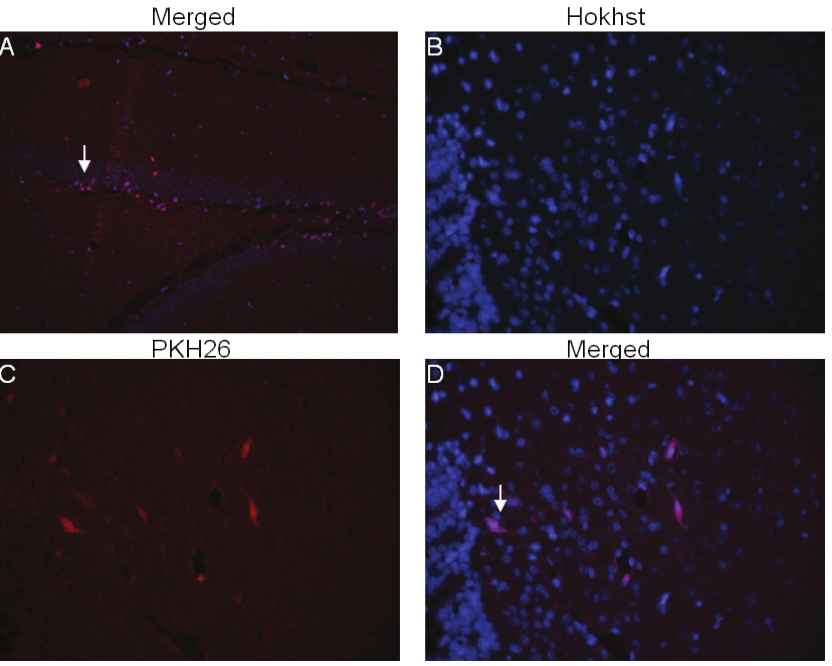
Figure 11: PKH 26 was used to determine stem cell migration into the brain. The sections were obtained 150 days after intravenous injection (Original magnification A: × 20. B, C, D: ×